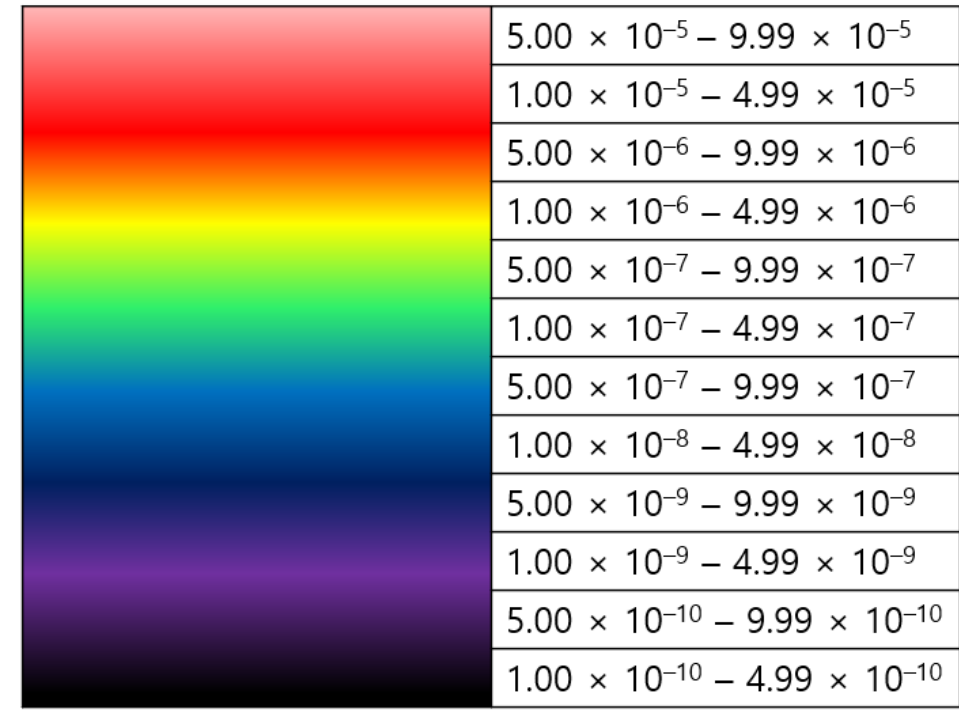
Figure 6. IR contours.